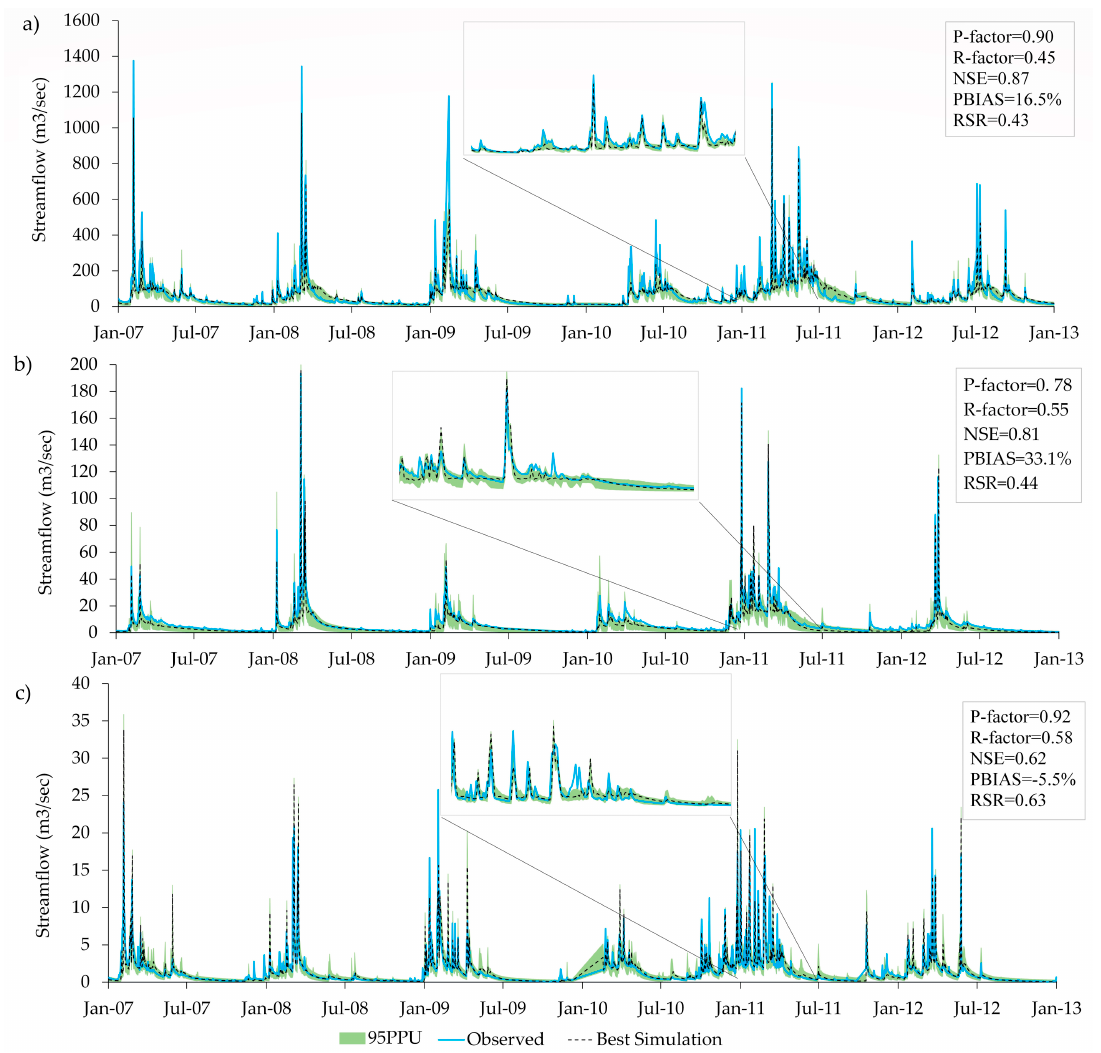
Figure 5. Daily streamflow validation (the period between 2007 and 2012) and 95PPU: ( a ) Tung Oil station; ( b ) Glenn Allyn station; and ( c ) Fisher Creek station.